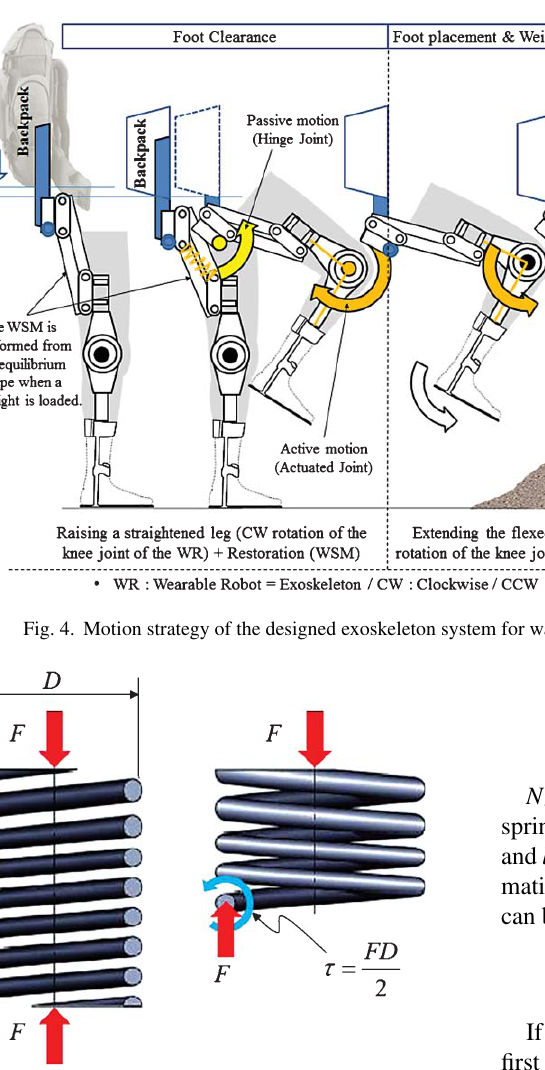
Fig. 5. Spring design